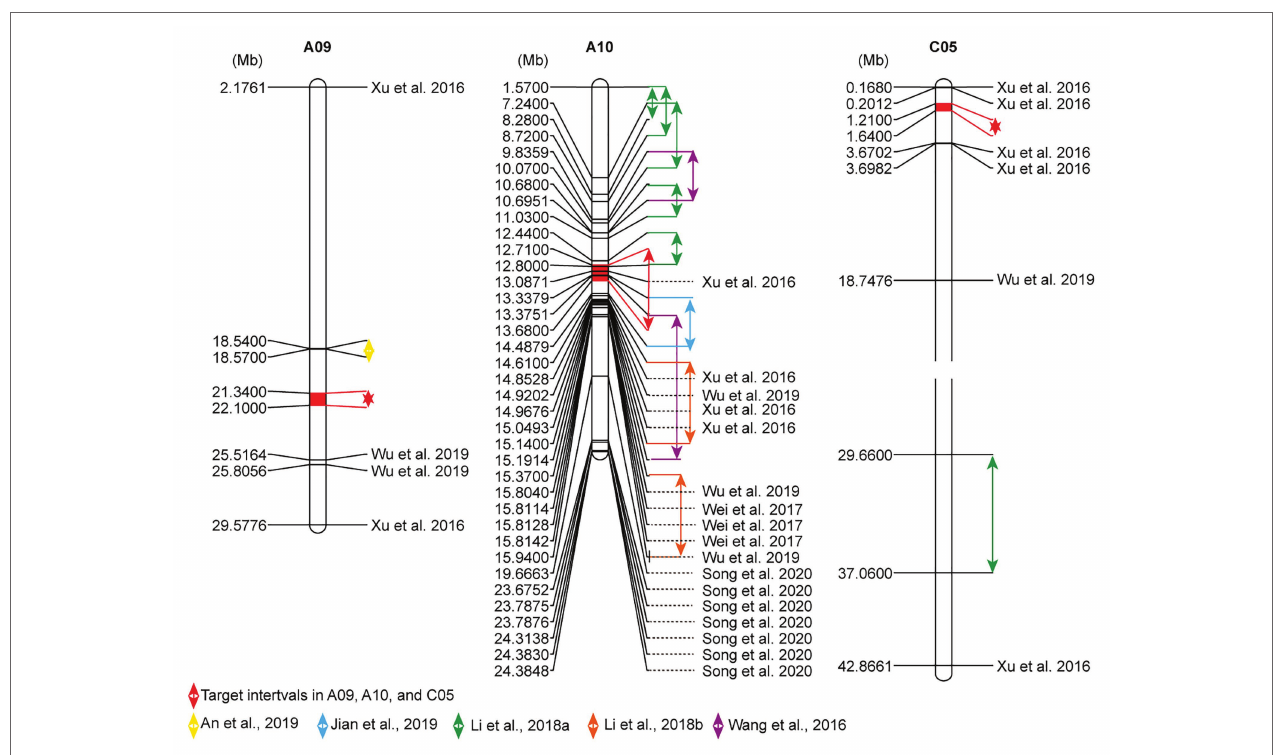
FIGURE 3 | Comparison of flowering-time sites of A09, A10, and C05 chromosomes between current and previous studies. The physical locations related to flowering time were arrayed by MapChart 2.2 software. The highlighted fill segments with red double arrows expose the present target intervals. Other collected QTL intervals also are annotated by double arrows, and significantly linked single nucleotide polymorphisms (SNPs) with flowering time were noted with the black reference.